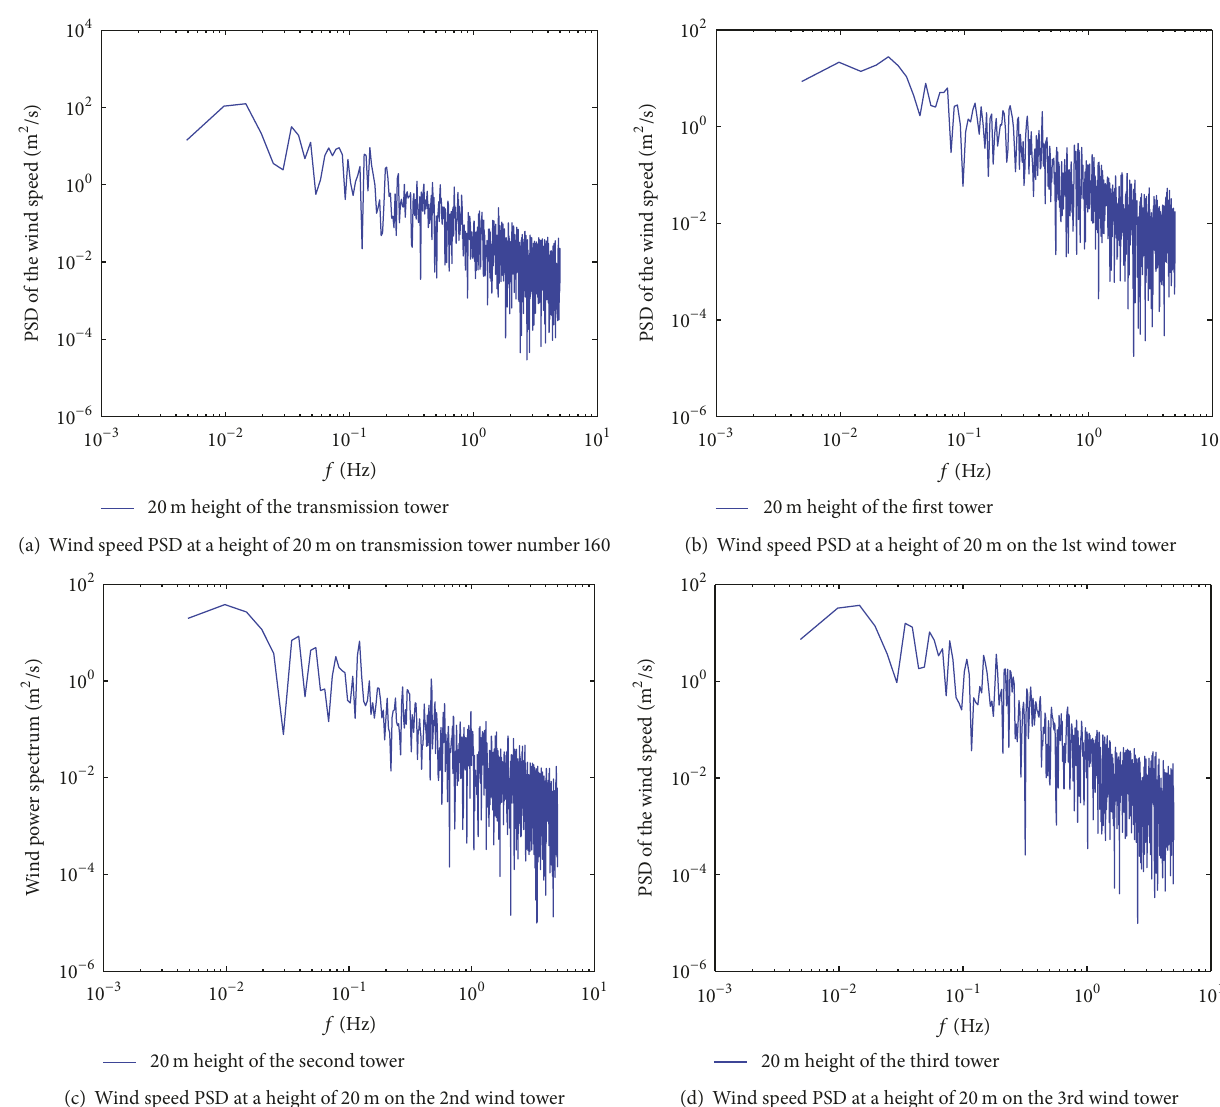
Figure 7: The fluctuating wind speed PSD recorded by the anemometers at each field measuring location of the transmission lines.